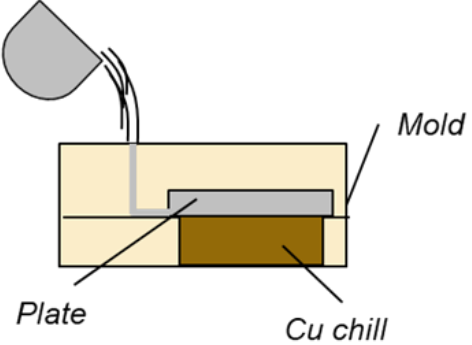
Figure 1. Schematic cross section of chemically bonded sand mold with integrated copper chill used to produce cast plates.